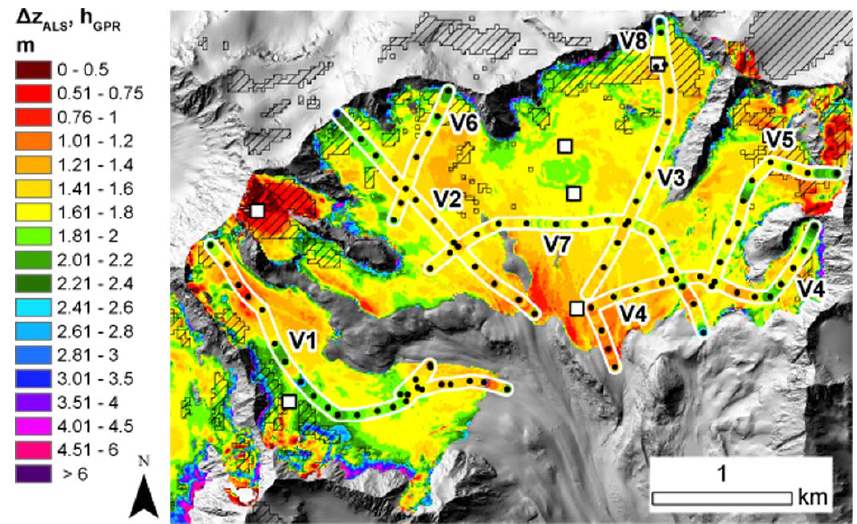
Fig. 6. Spatial distribution of ALS-derived surface elevation changes for for 10 October 2010 to 23 April 2011. Snow depths calculated from GPR measurements along the profiles at Vernagtferner plotted in the same colour-scale. Black dots indicate locations of snow depth probing. Locations of snow pits are shown as white squares. Snow covered areas derived from Landsat image of 31 August 2009 (LSC) are striped.